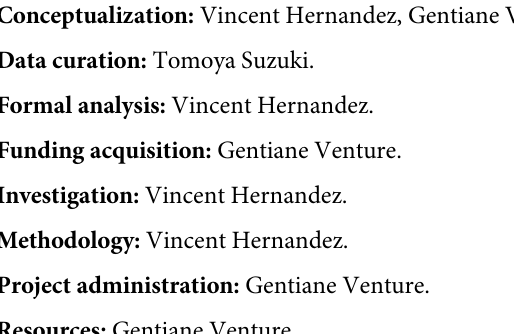
S1 Fig. Normalized confusion matrix. S2 Fig. Sankey